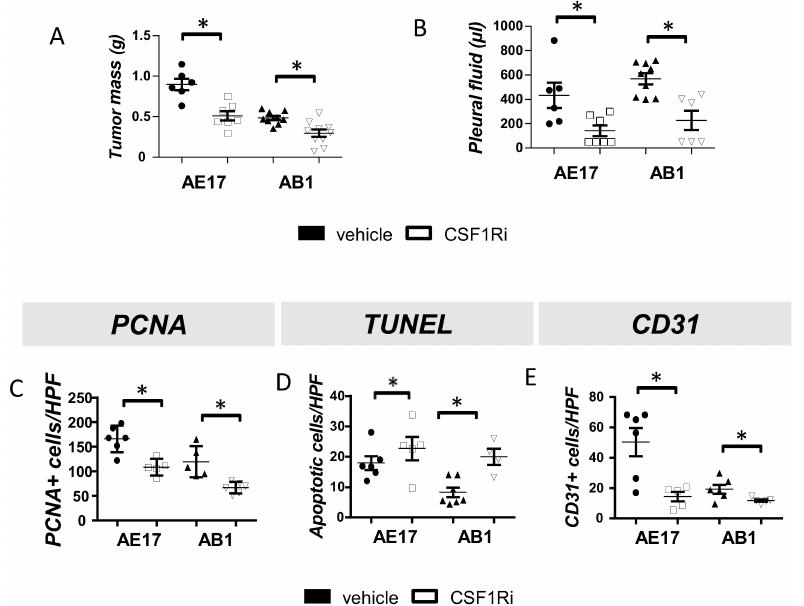
Figure 1. CSF1R inhibition attenuates murine mesothelioma progression by abrogating tumor cell proliferation and tumor angiogenesis and enhancing tumor cell apoptosis in vivo. AE17 and AB1 cells were intrapleurally injected into syngeneic C57Bl/6 and Balb/c mice, respectively. Mice were given BLZ945 inhibitor (200 mg/kg b.w., p.o.) or vehicle once daily. Fourteen days later, the mice were sacrificed, and the tumors were excised and weighed ( A ), and the pleural fluid was retrieved and quantified ( B ). Data presented as mean ± SEM, n = 6–10 from three independent experiments, * p < 0.05 compared to vehicle by 2-tailed students’ t -test. ( C ) Proliferating tumor cells were visualized upon staining for PCNA. ( D ) Tumor cell apoptosis in tumor tissues was evaluated by a TUNEL assay. ( E ) Tumor angiogenesis was evaluated in tissue sections from the vehicle- or BLZ945-treated animals upon CD31 staining. Data are presented as mean ± SEM, n = 5–6, * p < 0.05 compared to vehicle by 2-tailed students’ t -test. HPF: High Power